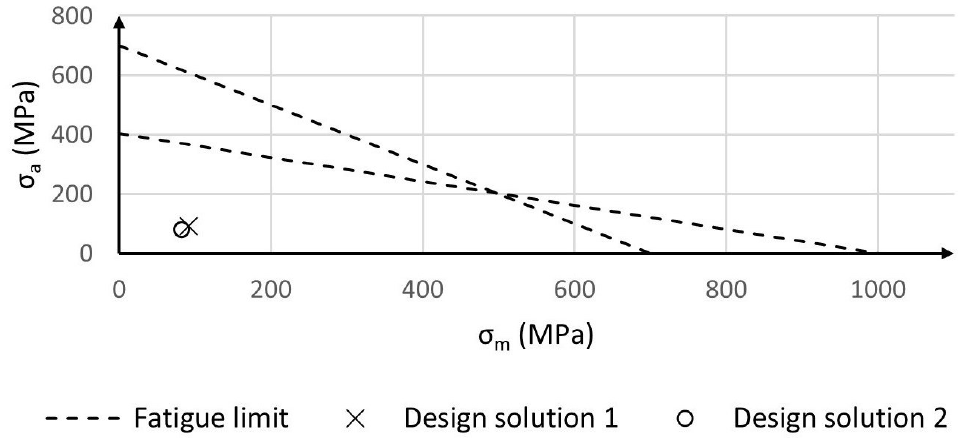
Figure 10. Haigh’s diagram for the two proposed design solutions.